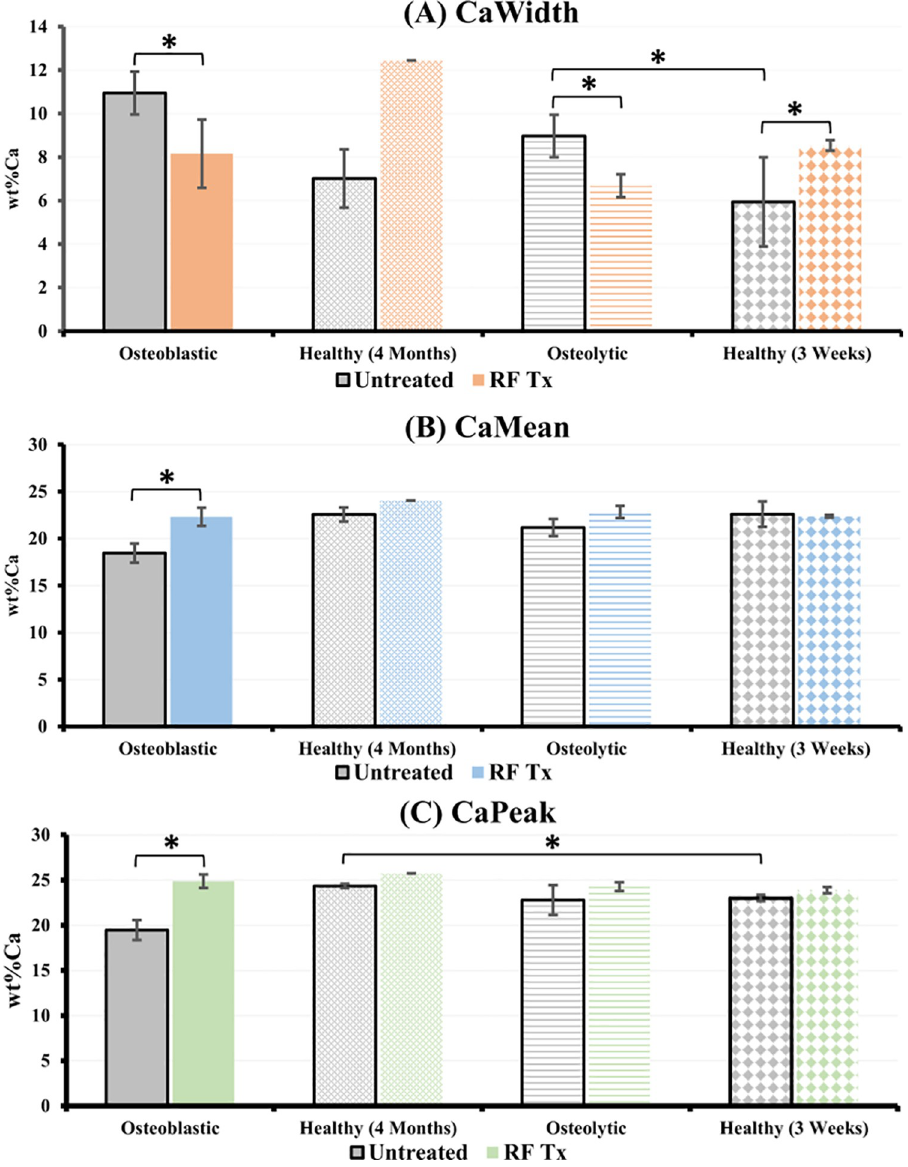
Fig 5. Mineralization profile of bone tissue. RFA-induced bone mineral density distribution (BMDD) changes in healthy femora and femora with metastatic lesions calculated from BSE images. The mineralization profile (a) Calcium Width (CaWidth) b) Calcium Mean (CaMean) and c) Calcium Peak (CaPeak)) of healthy and bone with metastatic lesions is modified post treatment. � Represents a significant difference between indicated groups (p < 0.05).